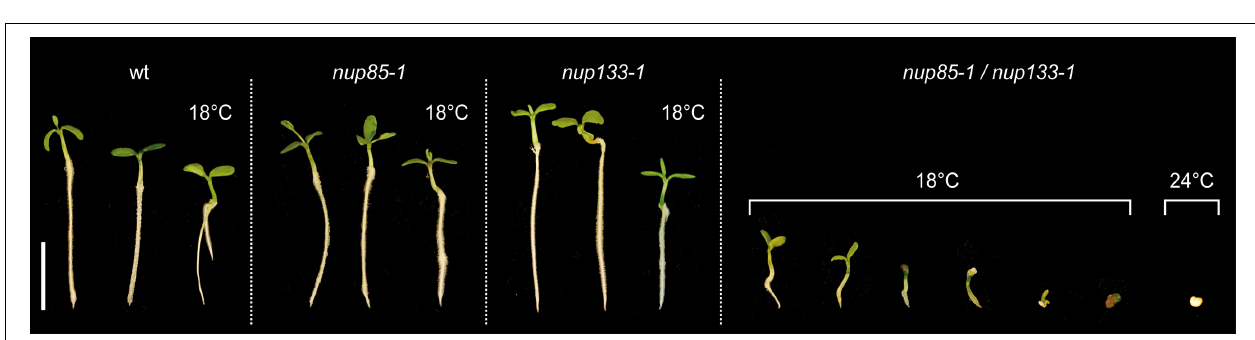
still develop, while at higher temperature (24 ◦ C), plant development was arrested at the early germination stages. Plants and undeveloped seeds were cultivated for 16 days. Scale bar =